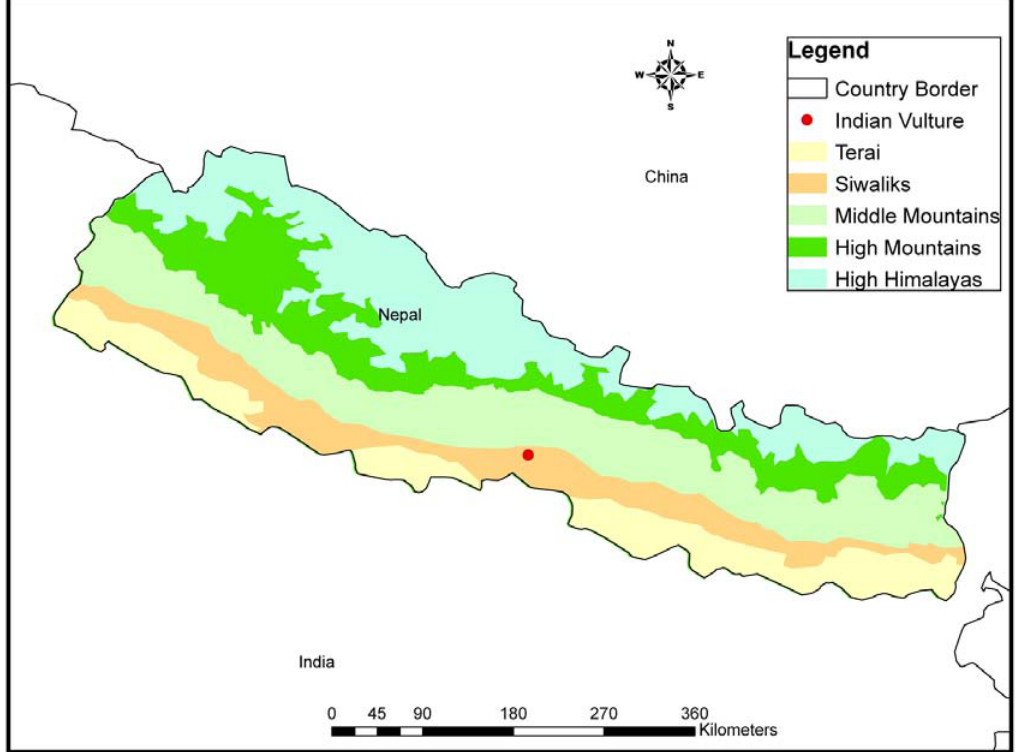
Figure 3. Indian Vulture distribution in Nepal. (DeCandido et al. 2012; Subedi & DeCandido